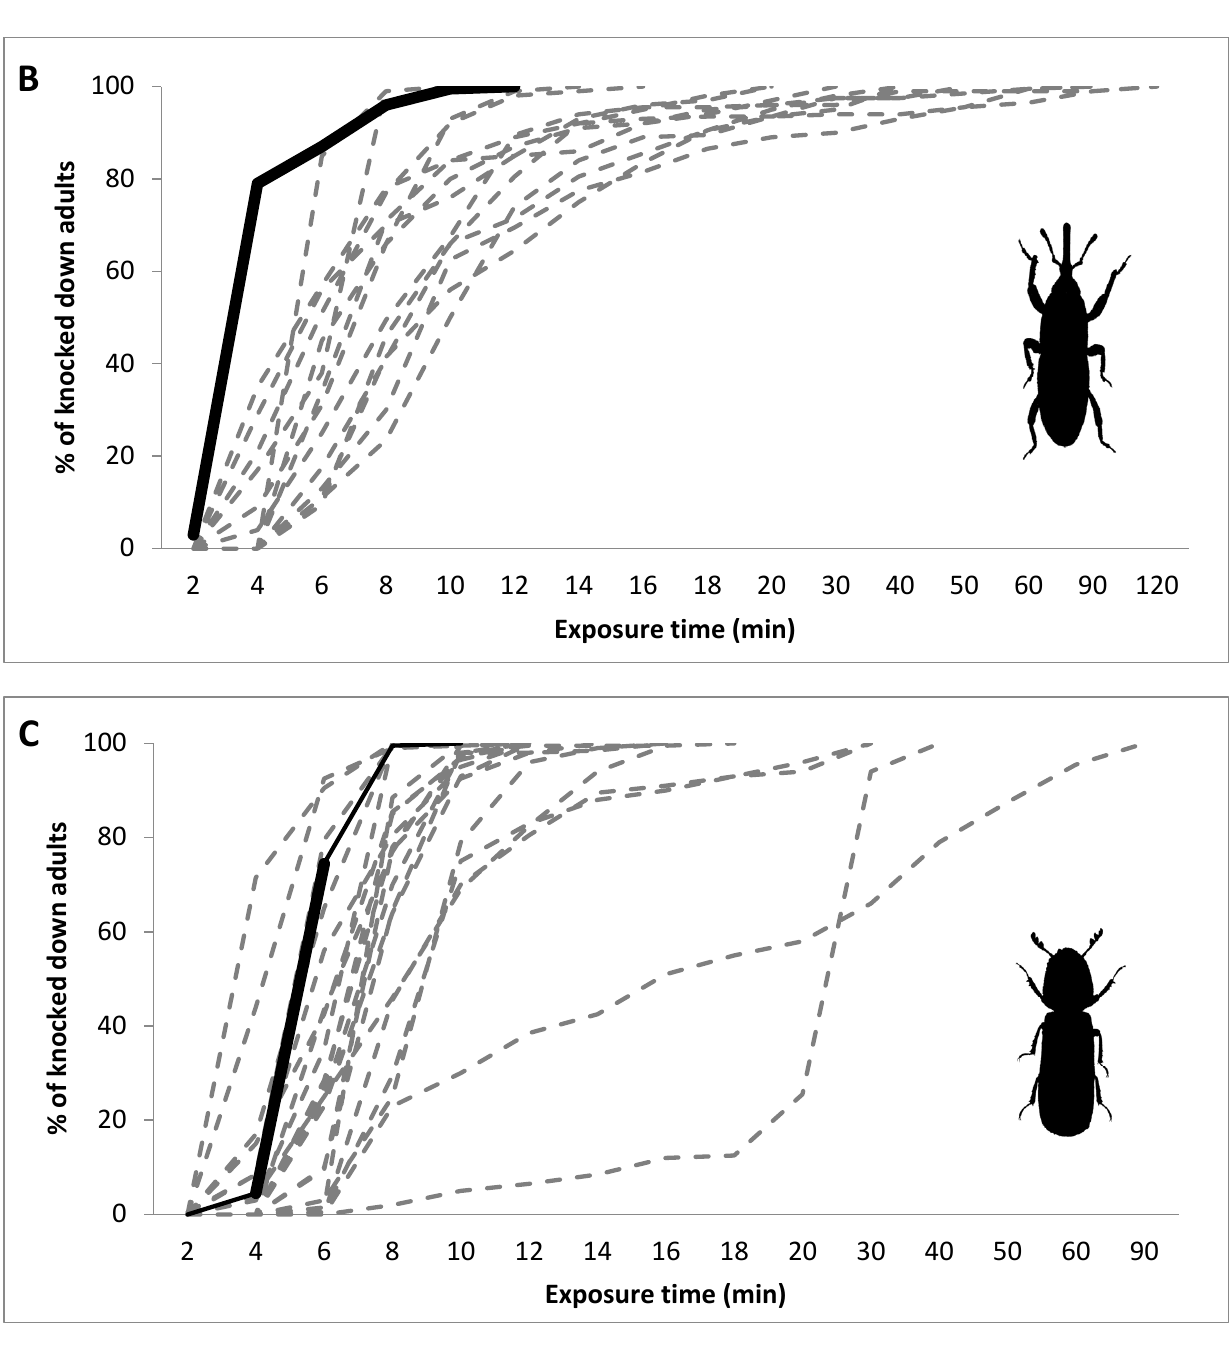
Figure 1. ( A – C ) Percentage of knocked down adults of different populations of the three tested species of stored-product pests ( A — O. surinamensis ; B — S. oryzae ; C — R. dominica ) after exposure to phosphine at 3000 ppm for different observation intervals (in minutes). The black, solid line shows the benchmark values for the laboratory population; the grey, dashed lines show the values for the field populations.